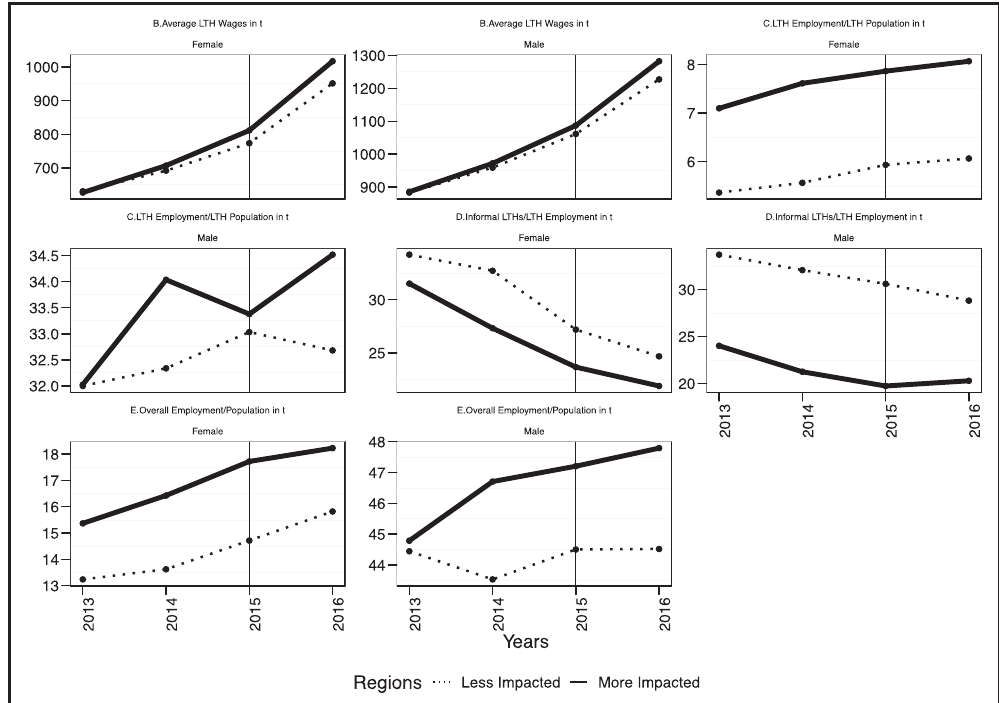
Figure 7 Testing parallel trend assumption: Labor market outcomes of workers with no high school degree during the period of